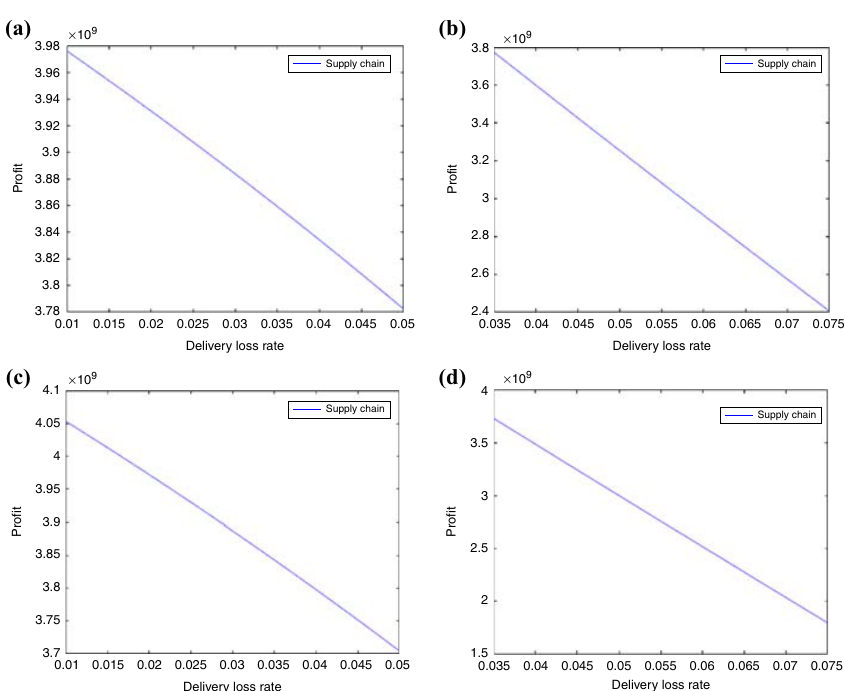
Figure 2. The impact of water delivery loss rate change on the profit of IBWT supply chain without/with fairness concern